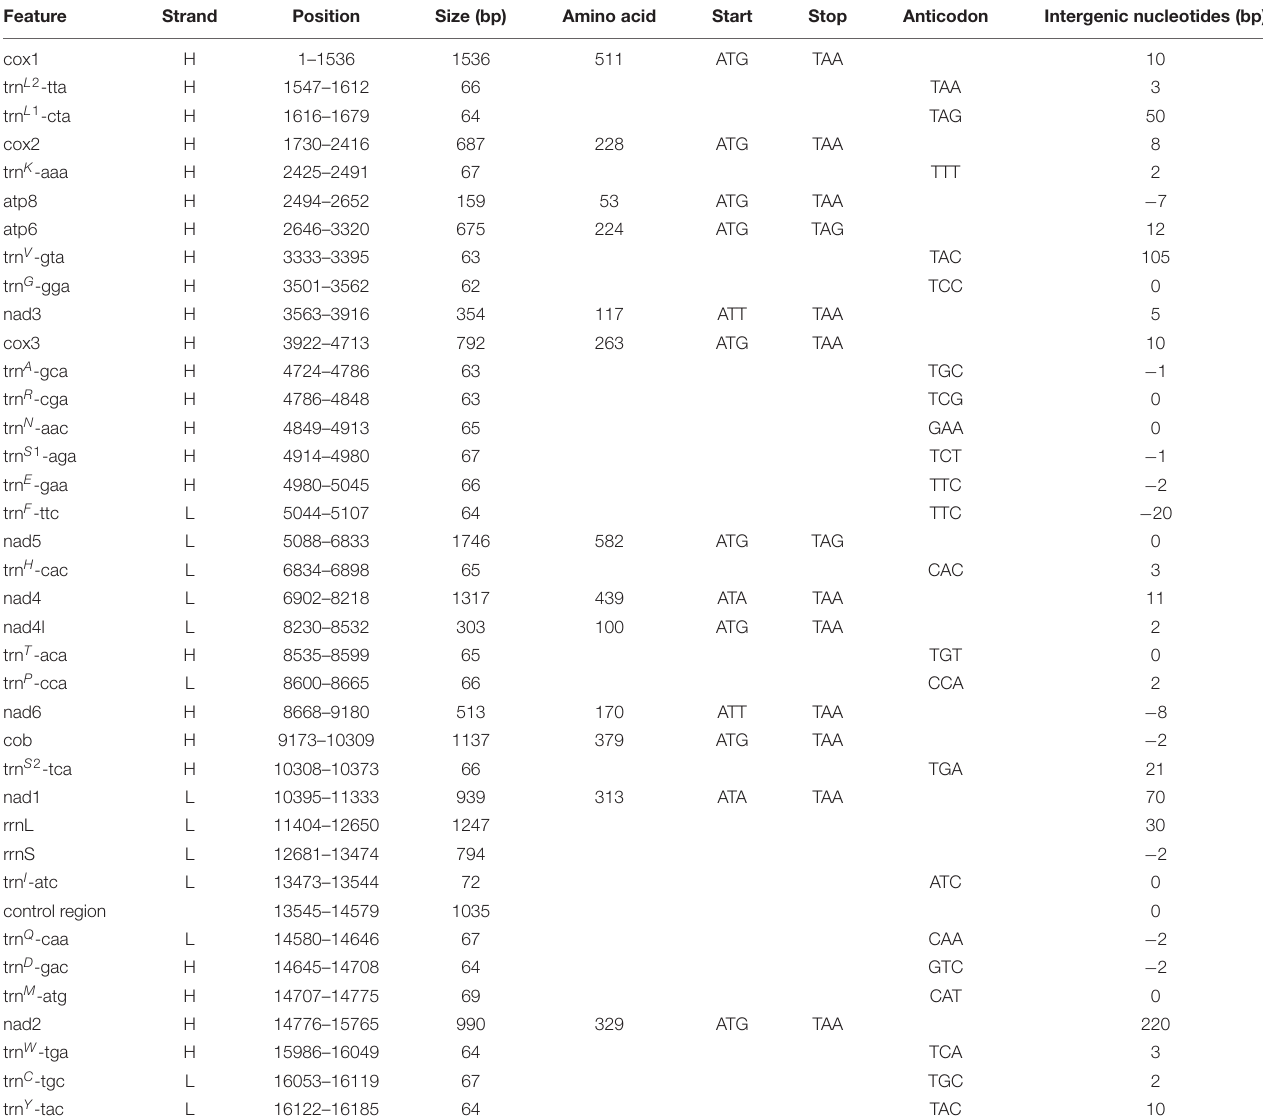
TABLE 3 | Organization of the mitochondrial genome of Eiconaxius serratus sp. nov.